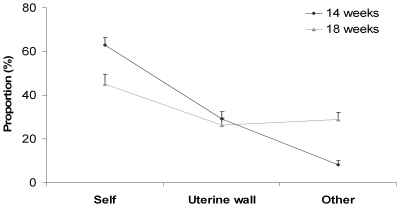
Schematic representation of the analysis considering the proportion of each type of movement.Proportion of movements performed by the foetuses towards the self, outer-directed movements and movements towards the co-twin at the 14th - (solid line) and 18th – (dashed line) week of gestation. Error bars represent the standard errors of the means.